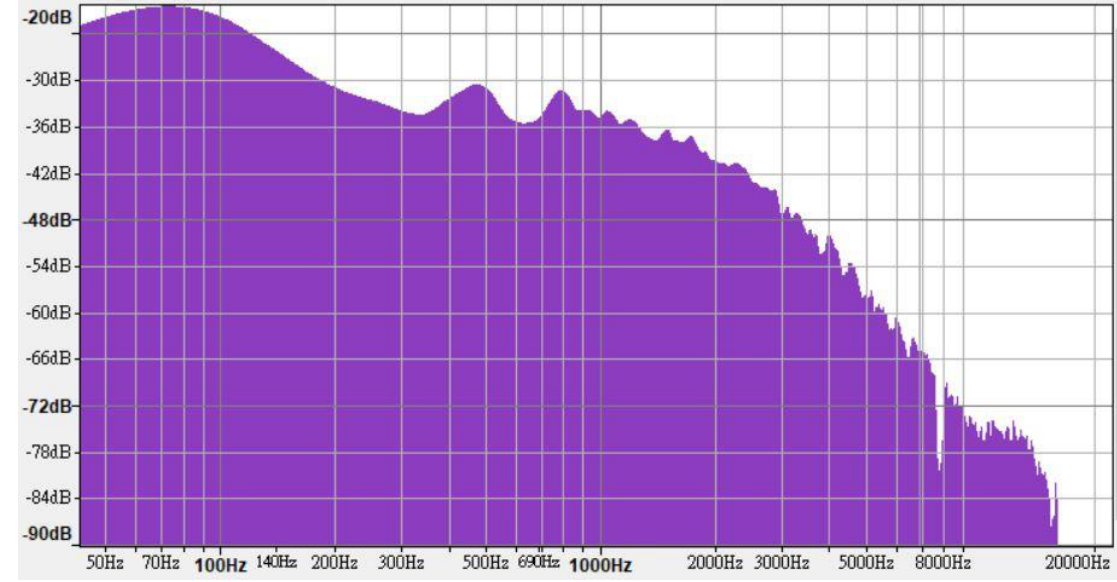
Figure 1. Frequency characteristics of traffic noise sample.